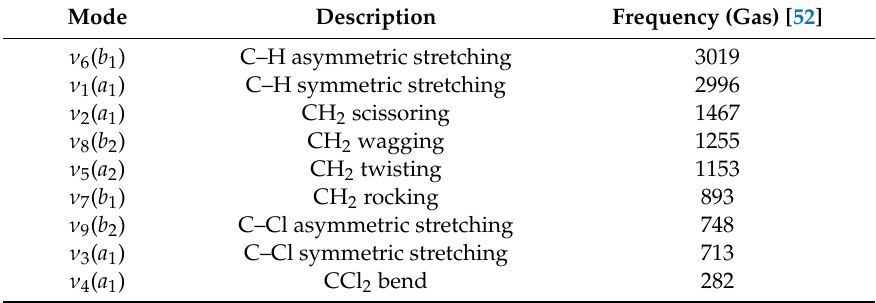
Table 3. Intramolecular vibrations of dichloromethane (CH 2 Cl 2 ). Experimental frequency is given in cm − 1